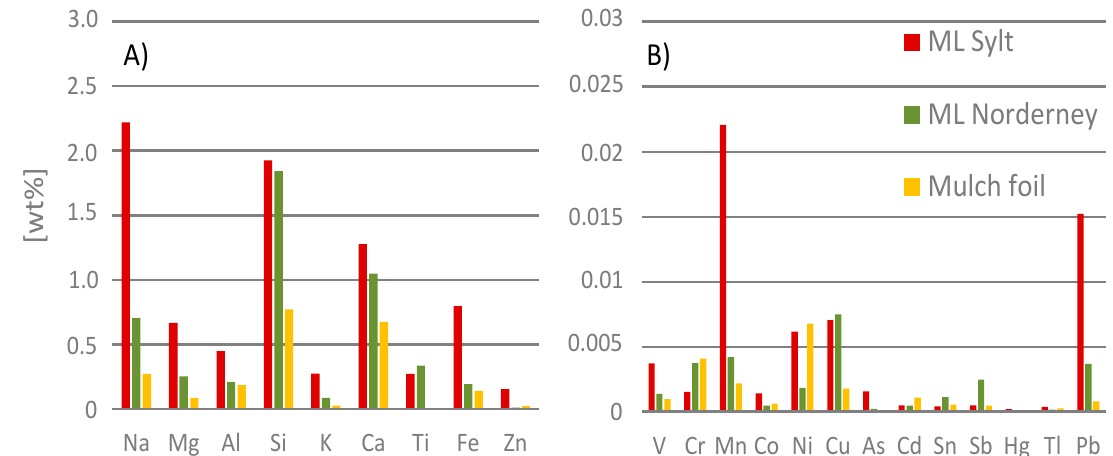
Figure 10. Mass fraction of selected elements in raw material determined by X-ray fluorescence (XRF) (n = 2). ( A ) shows detected elements with the highest mass fractions. ( B ) shows heavy metals mentioned in the German ordinance for waste incineration (17. BImSchV).